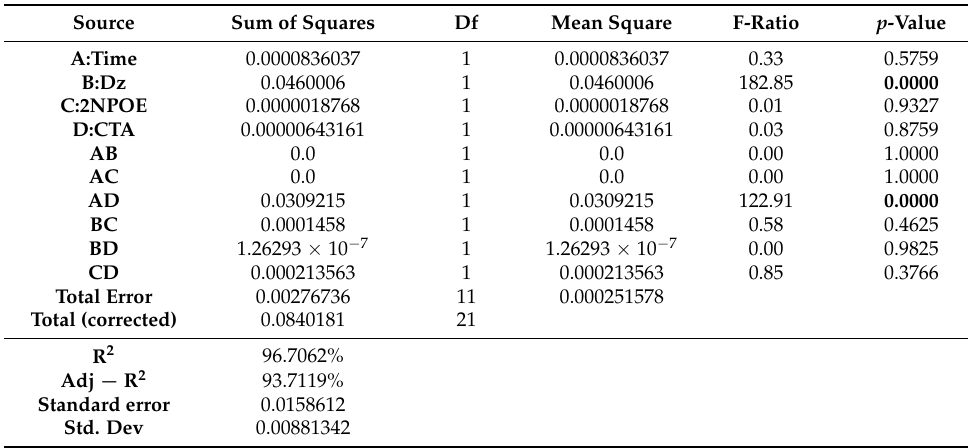
Table 3. Summary of the optimization results for the membranes prepared with PAN and THEP using M1 in the determination of Hg(II). Pb(II). and Cd(II). Coded and real values of the variables are